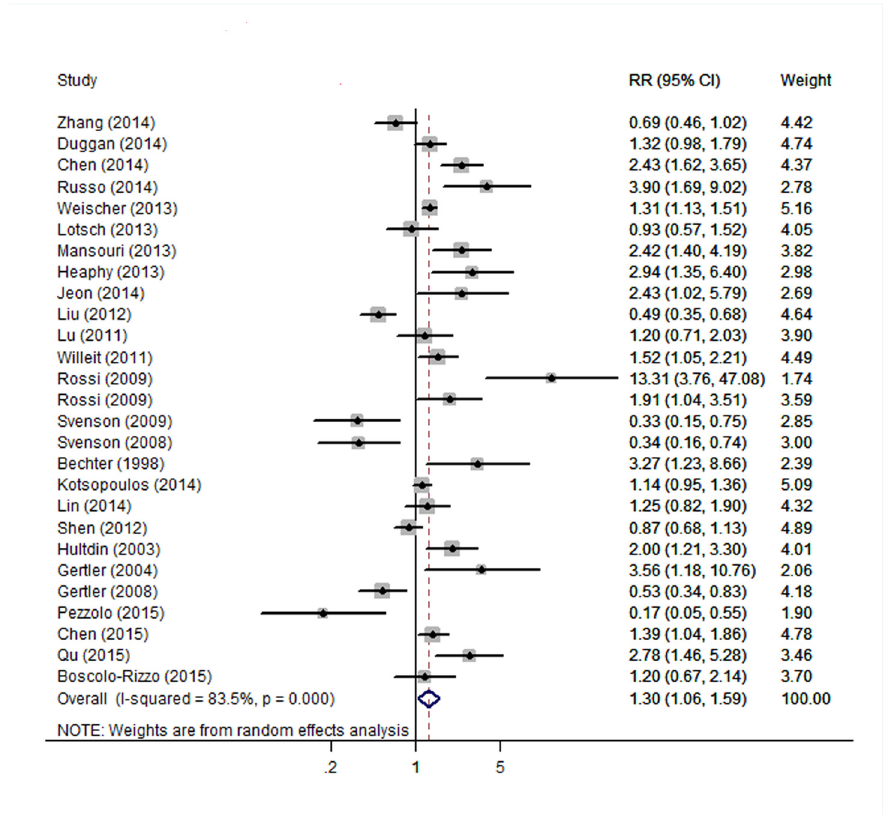
Fig 2. Forest plot for association between telomere length and cancer overall survival. Results are presented for random effects